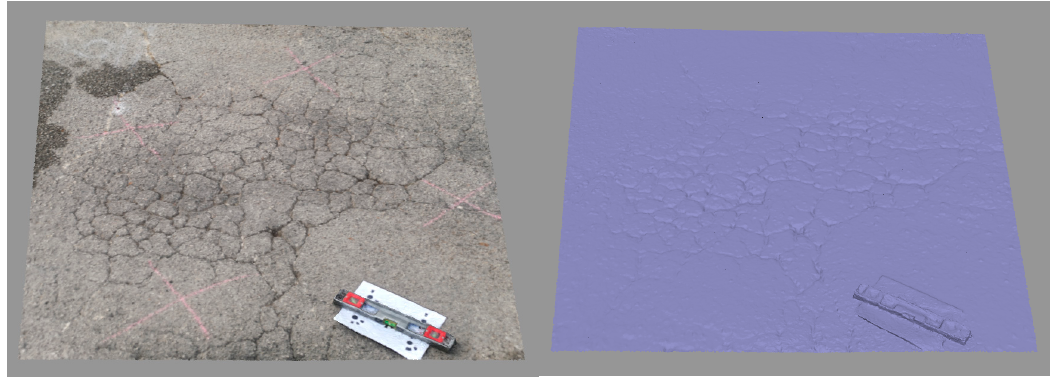
Figure 13. Model ( right ) and dense cloud ( left ) produced by imagery from Samsung Galaxy s9.